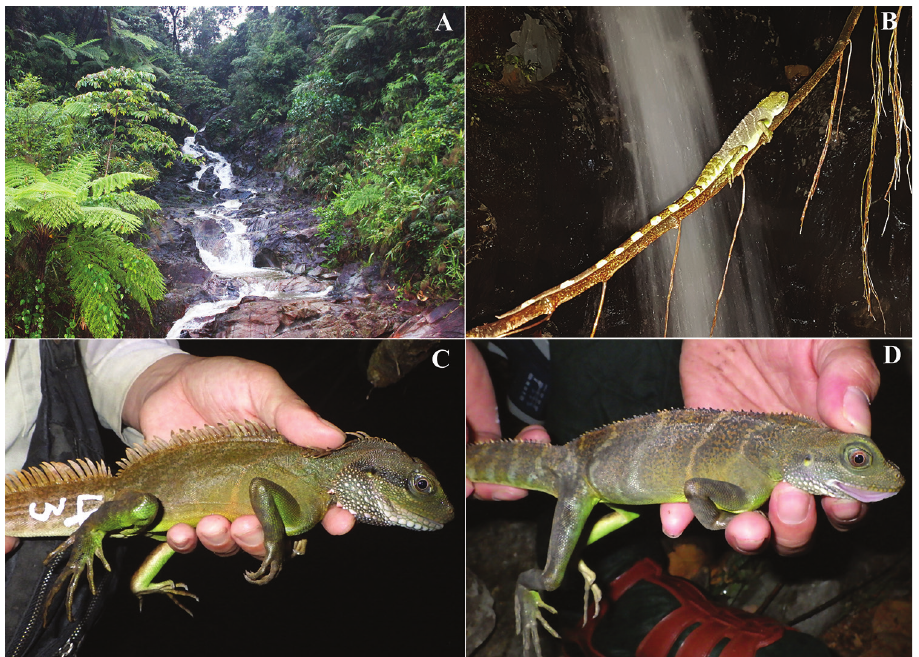
Figure 2. A Habitat of Physignathus cocincinus in Nam Dong District, Thua Thien Hue Province B Resting perch in front of waterfall C Adult male D Adult female. Photos: Hai